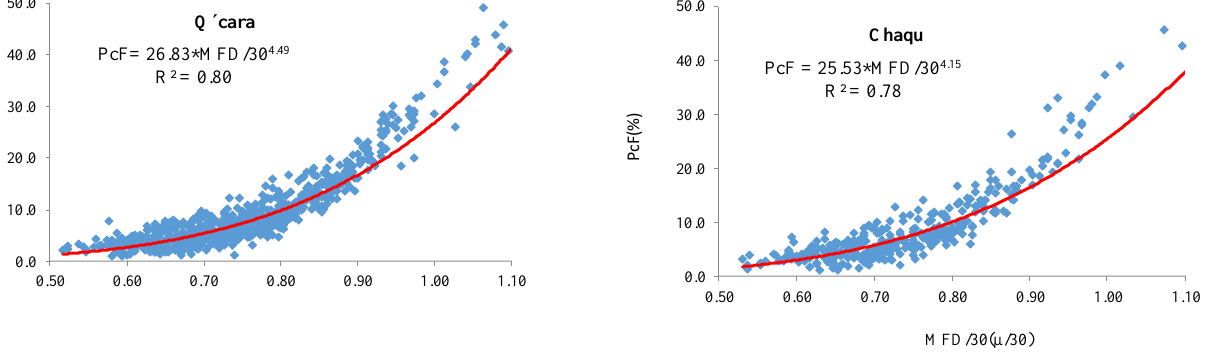
Figure 2. The percentage of fibres >30 µm on MFD/30 µm in two llama biotypes.